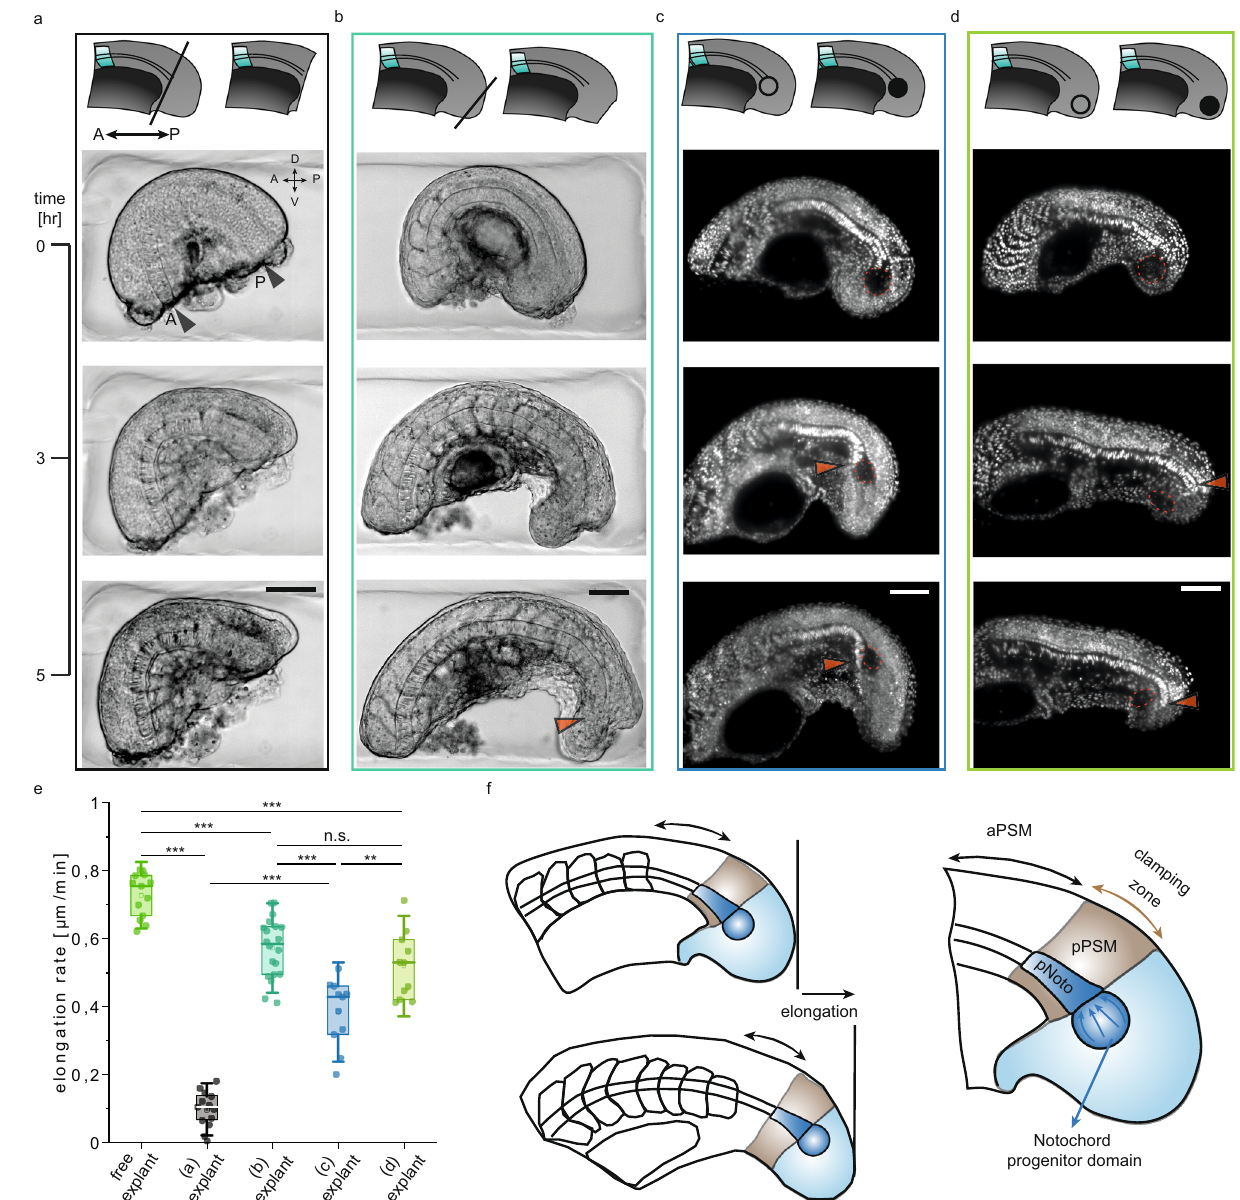
Fig.5|Micromanipulationstothetailbudshowthatcelladditiontotheendof the notochord from the notochord progenitor domain is required for tail elongation. Schematicsdescribingthemicromanipulationsareshownatthetopof each case. a Time-lapse BF images of a tail explant where the tail bud is removed using the microcautery device (A/P: anterior/posterior, D/V: dorsal/ventral). b Time-lapse BF images of a tail explant where the tip of the tail bud is removed using the electrocautery device. Orange arrow shows the location towards which the notochord elongates. The notochord progenitor domain is maintained intact. c Time-lapse fl uorescence imagesofaH2B-mCherrylabelled tailexplantwherethe notochord progenitor domain is ablated using laser microsurgery. Orange arrow showsthe locationwhere thenotochordbendstowards the ventral sideof the tail.